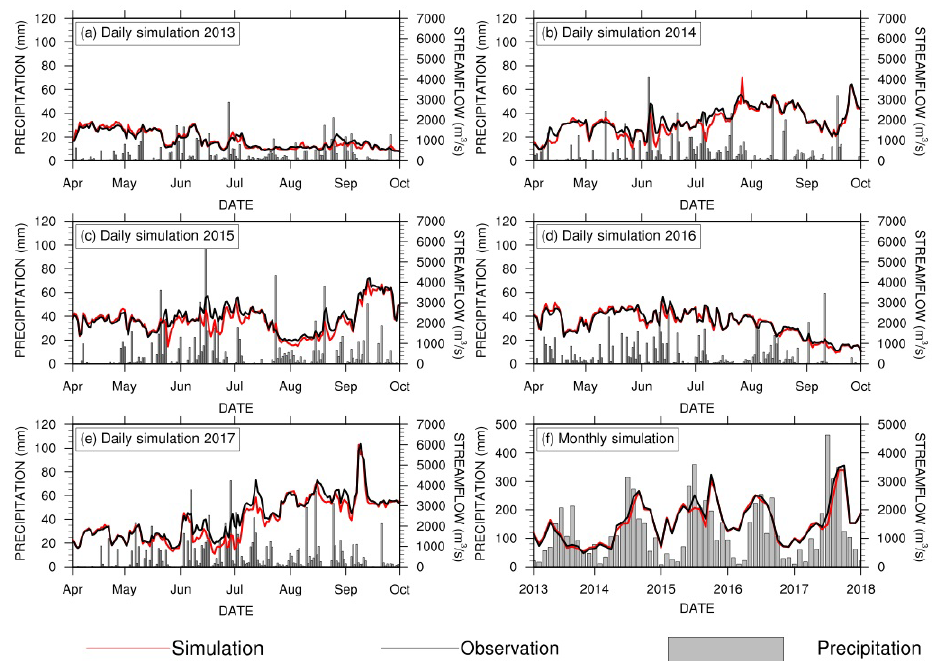
Figure 4. Evaluation of streamflow simulations at the Yantan hydrological gauge. The black and red lines are the observed and simulated streamflow. Panels (a) – (e) show daily streamflow, and panel (f) shows monthly streamflow. The gray bars represent daily (or monthly) precipitation.